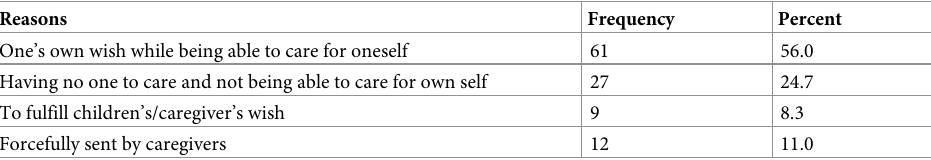
Table 3. Major reasons why older adults chose to move to old age homes (n = 109). Reasons Frequency Percent One’s own wish while being able to care for oneself 61